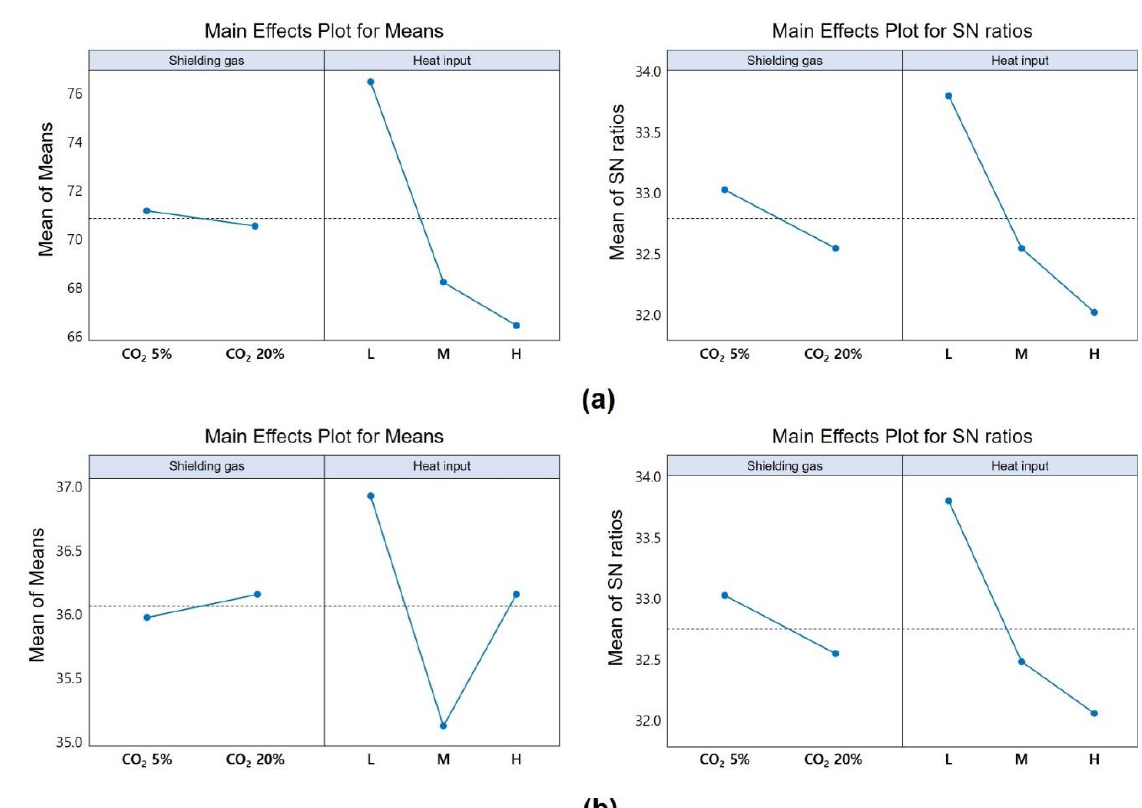
Figure 13. Toughness results of GMAW with CO 2 5% and 20% shielding gas and heat input at low temperature ( − 40 °C).